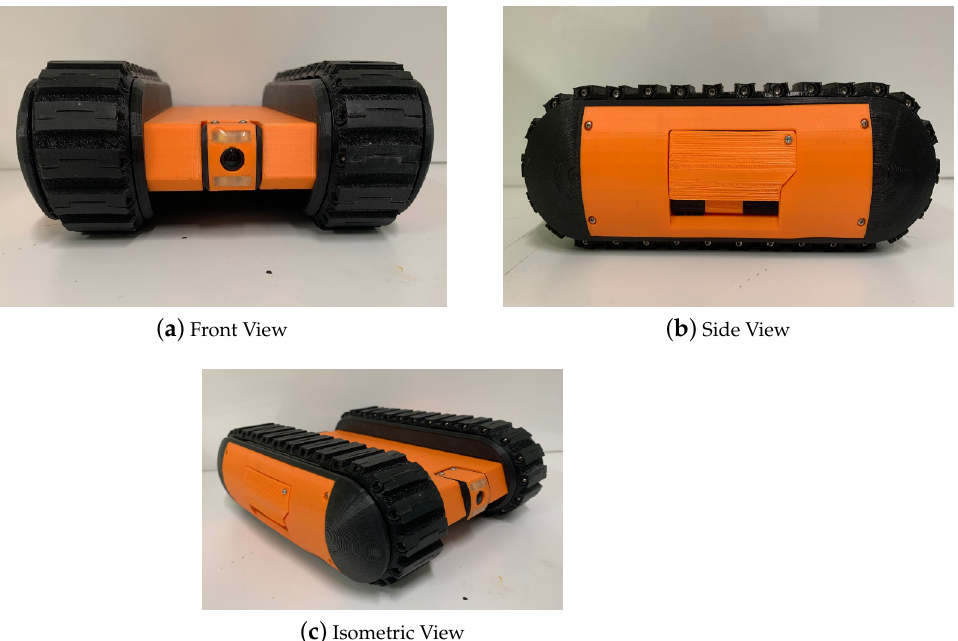
Figure 3. Different view of the Falcon Robot (Version